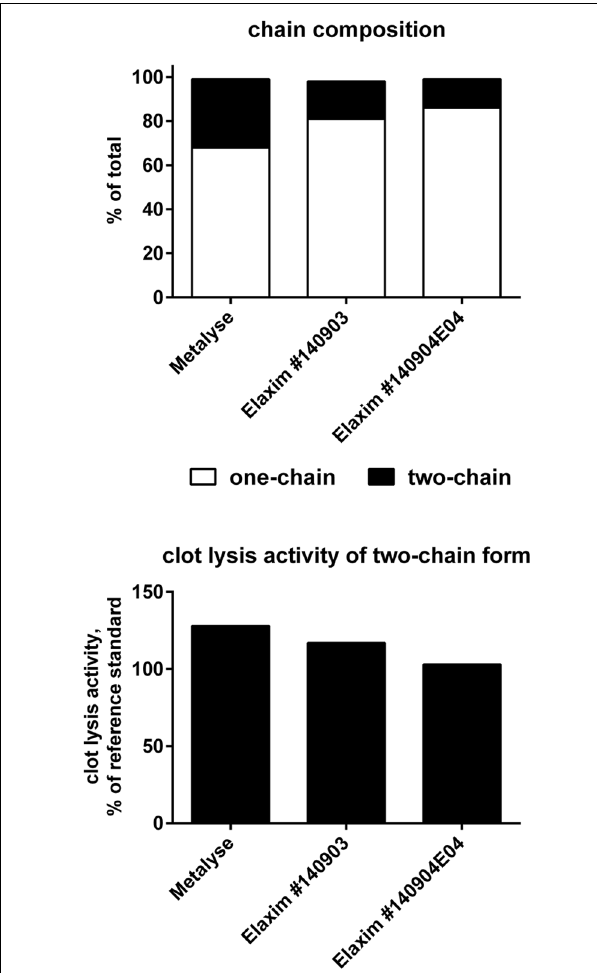
FIGURE 2 | Relative abundance of one- and two-chain form (upper panel) and in vitro clot lysis activity of Elaxim and Metalyse enzymatically converted to two-chain form (lower panel).